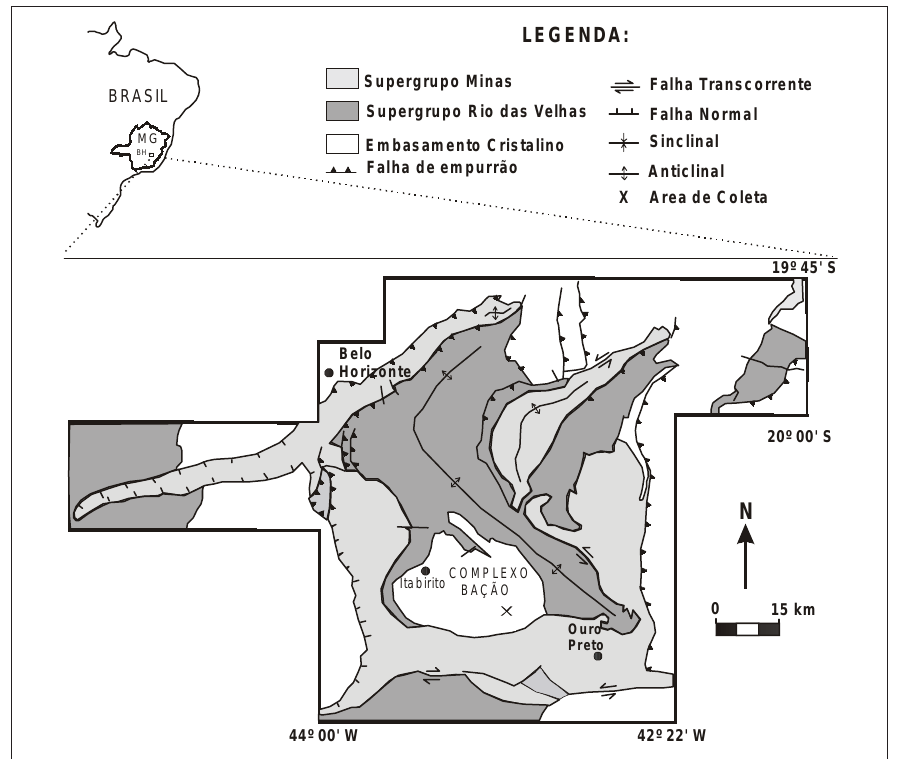
Figura 1. Localização da área de coleta de amostras de solos no Complexo do Bação